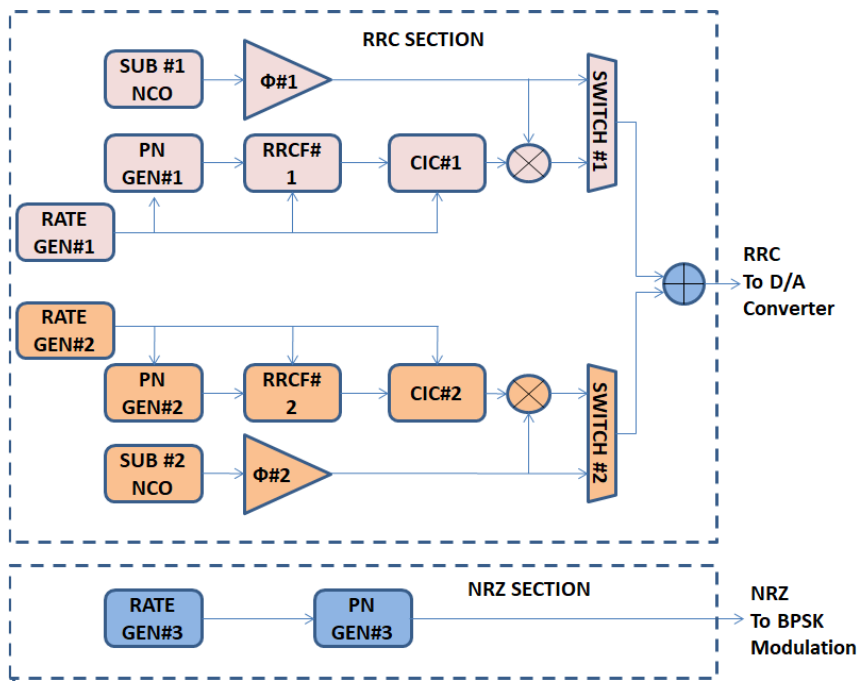
Figure 4. W- ∆ DOR core DSP